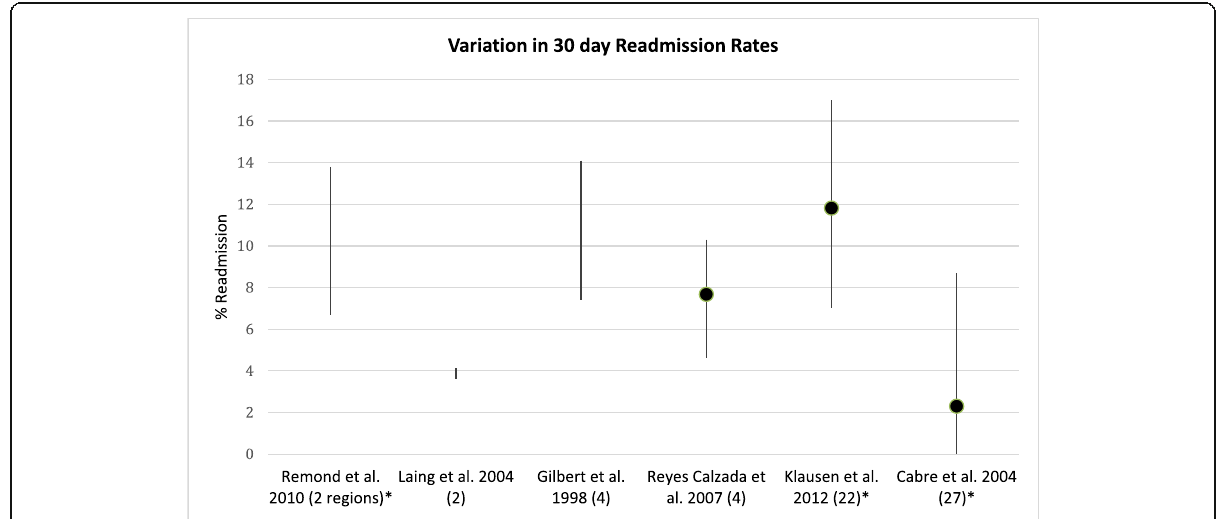
Fig. 3 Inter-hospital variation in all cause readmission rates across studies. Range represented as line, dot represents mean value where possible. * denotes a statistically significant result. ^ denotes no reported p value. The number in brackets represents the number of hospitals compared in the study, unless otherwise stated. Data presented from McCormick et al. is 14-day post discharge readmission